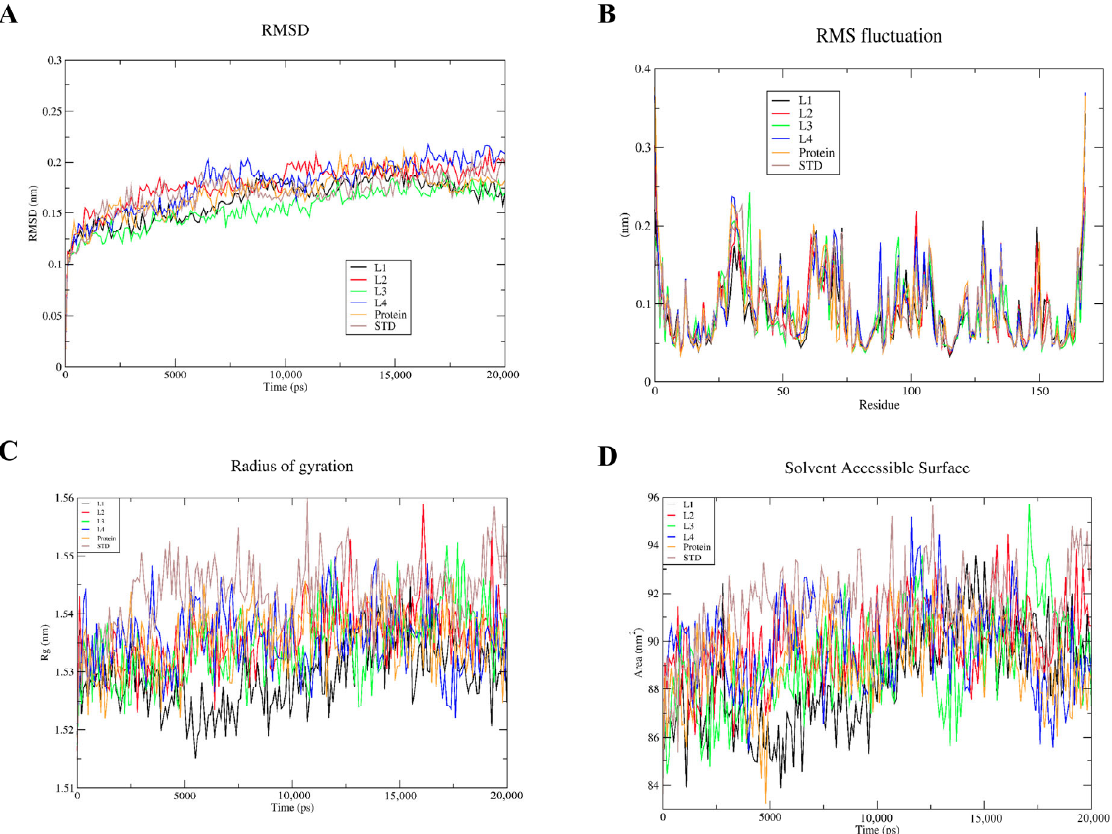
Figure 7. Root ‐ mean ‐ square deviation (RMSD) ( A ), root ‐ mean ‐ square fluctuation (RMSF) ( B ), ra ‐ of gyration (Rg) ( C ), and the solvent-accessible surface area (SASA) ( D ) of the docked complexes dius of gyration (Rg) ( C ), and the solvent ‐ accessible surface area (SASA) ( D ) of the docked com ‐ plexes of BI ‐ 2852 (std) 5 ‐ Dehydroxyparatocarpin K (L1), Carpachromene (L2), Sanggenone H (L3), of BI-2852 (std) 5-Dehydroxyparatocarpin K (L1), Carpachromene (L2), Sanggenone H (L3), and and Kuwanol C (L4), with the KRAS G12D mutant and KRAS G12D mutant alone (apoprotein). Kuwanol C (L4), with the KRAS G12D mutant and KRAS G12D mutant alone